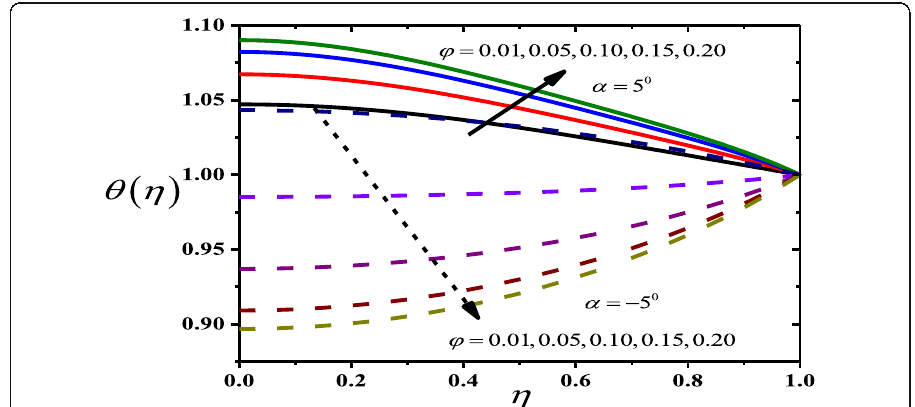
Fig. 17 Temperature vs. φ in shrinking divergent and stretching convergent